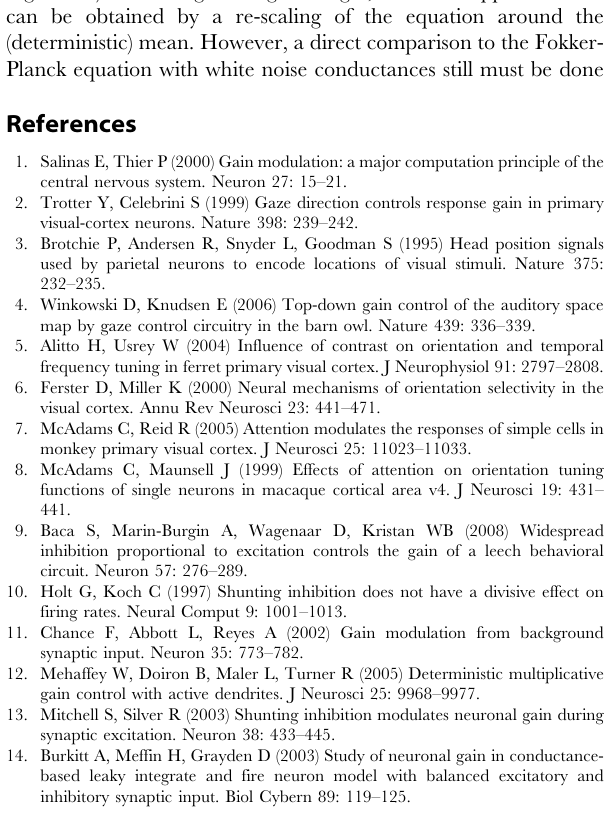
Figure S1 The advection/diffusion coefficients. (A) The func- tions d e/i 0 (v). (B) The functions d e/i 1 (v). Parameters: PSP = + 0.5 or 2 0.5 mV (see main text for an explanation), t m = 20 ms, 2 80 mV, e 2 70 mV, V 2 55 mV, e e i = r = th = e = 0 mV. Found at: doi:10.1371/journal.pcbi.1000365.s001 (8.28 MB TIF) Text S1 Fokker-Planck approximation to full density equations Found at: doi:10.1371/journal.pcbi.1000365.s002 (0.01 MB